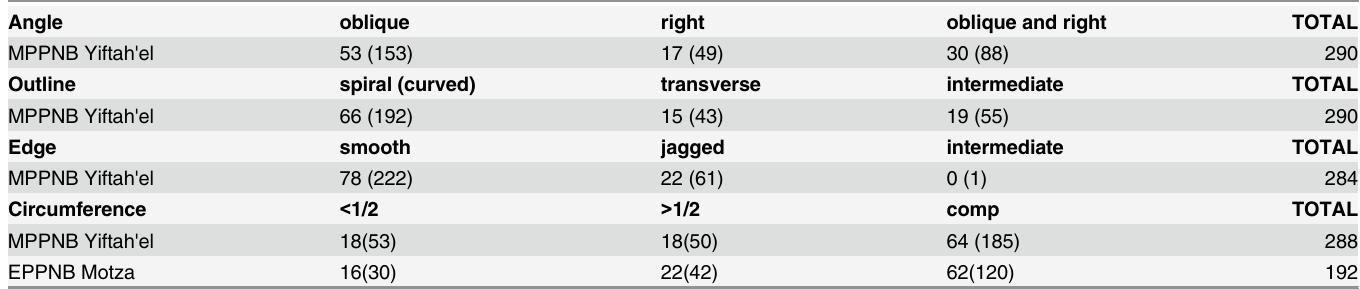
Comparative shaft circumference data from EPPNB Motza. Values outside parentheses are = percentages, inside parentheses are = sample size. Fracture terms and de fi nitions follow Vila and Mahieu